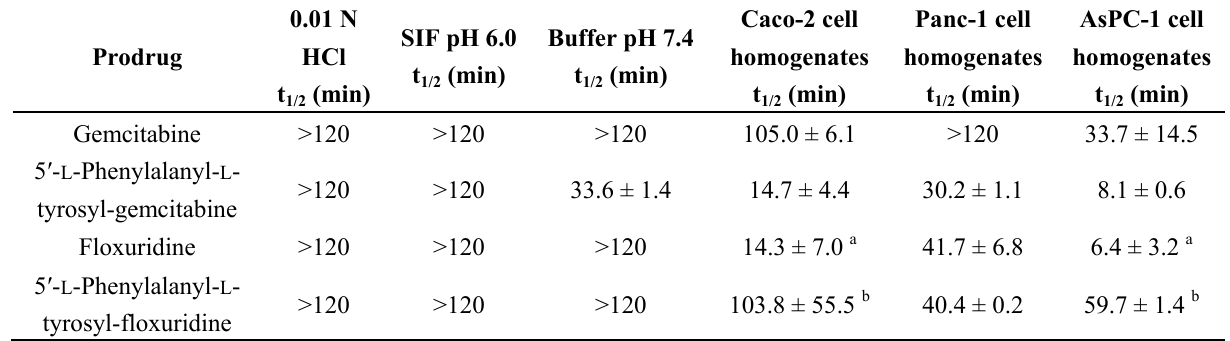
Panc-1 cell homogenates